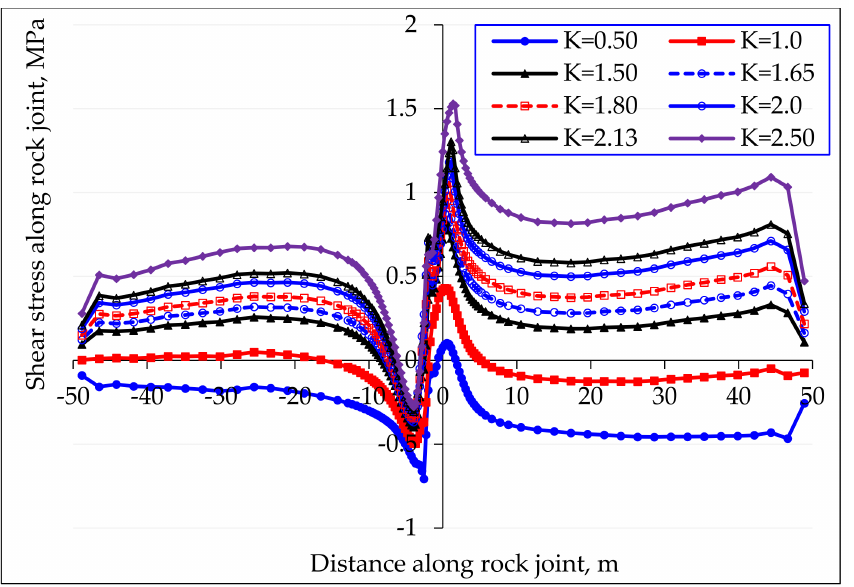
Figure 13. Shear stress along a rock yielded joint that passes below the tunnel opening at various in situ stress ratios K.